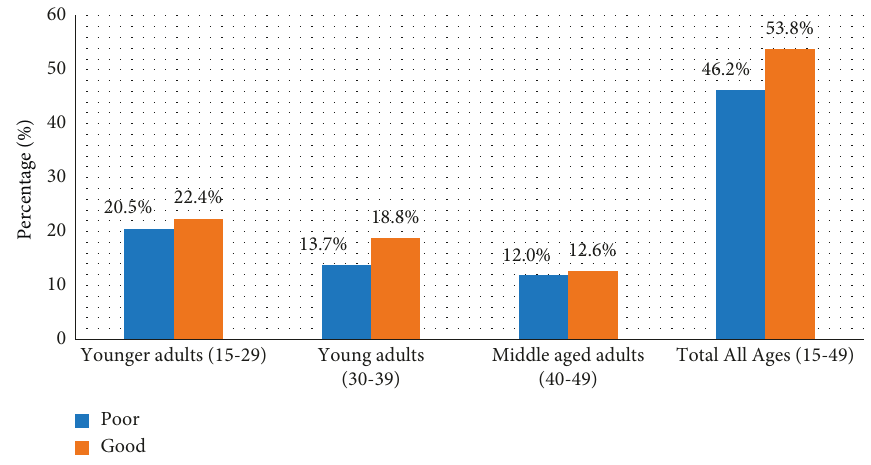
Figure 3: Level of knowledge of CKD risk factors among participants by the age